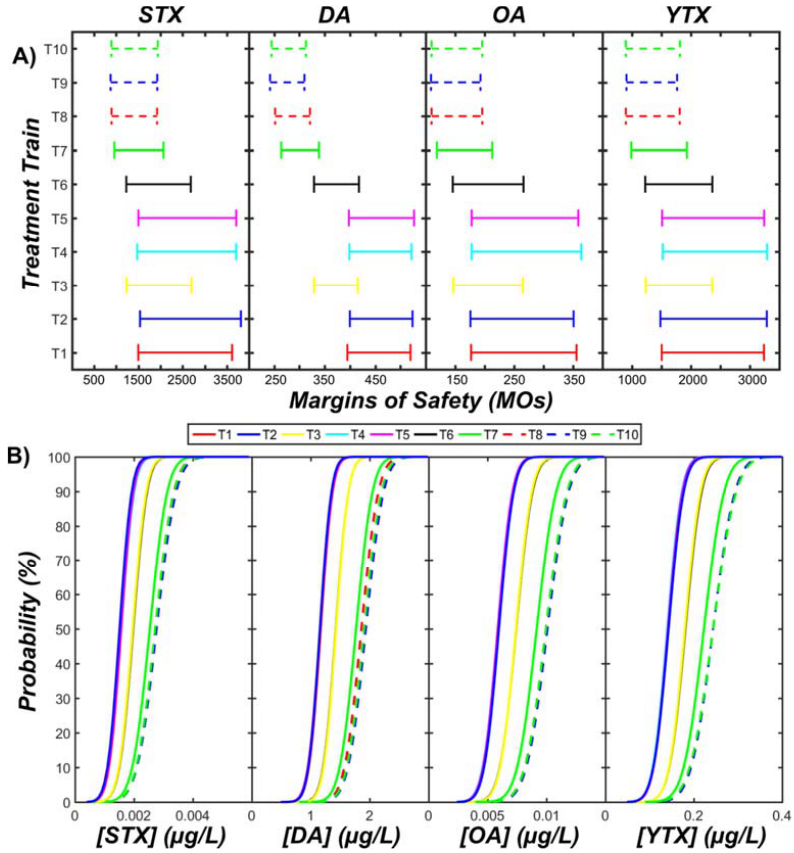
Figure 6. Summary of ( A ) margins of safety for various algal toxins in the permeate water and ( B ) cumulative probability distributions of toxin concentrations in the permeate water.